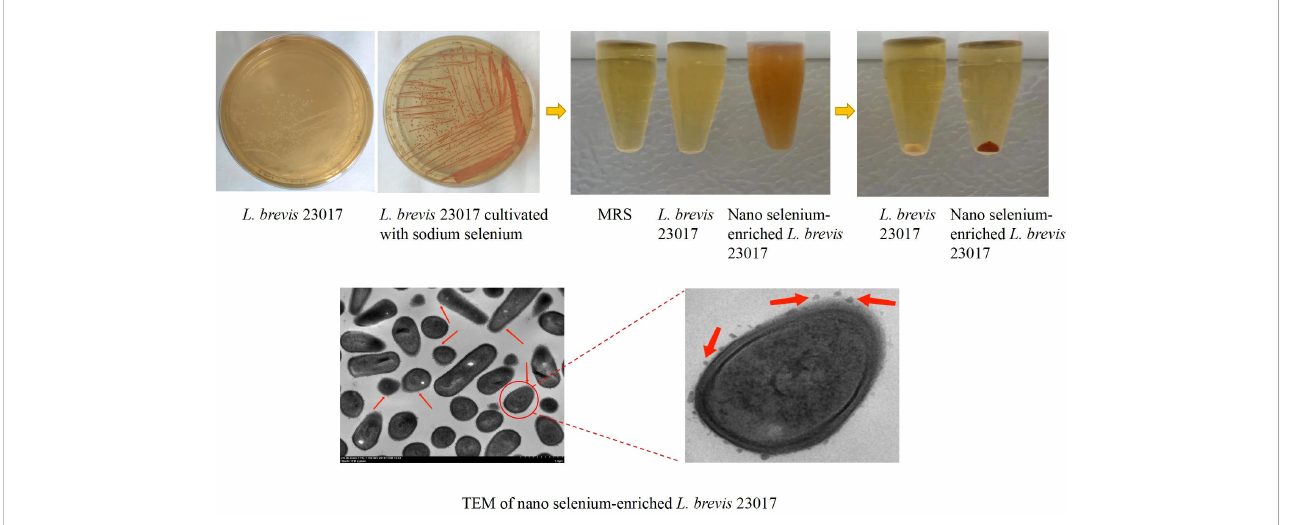
FIGURE 1 Synthesis and characterization of nano selenium-enriched L. brevis 23017. L. brevis 23017 cultivated under sodium selenite stress (30 m g/ml) led to reduction of selenite ions (Se IV ) into extracellular elemental Se (Se 0 ) nanoparticles observed by transmission electron microscopy (TEM), and visible as red color. The red arrow in the fi gure refers to